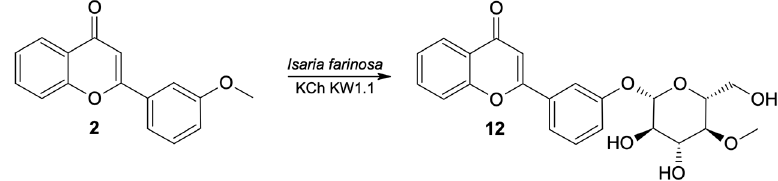
Figure 4. Biotransformation of 3 ′ -methoxyflavone ( 2 ) by I. farinosa KCh KW 1.1.